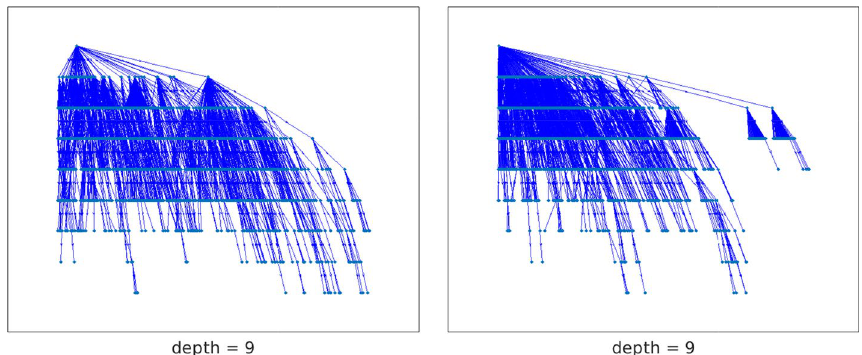
Fig. 16 Network twitter (3656 vertices): out-trees with root vertices 1768 (left) and 1324 (right)